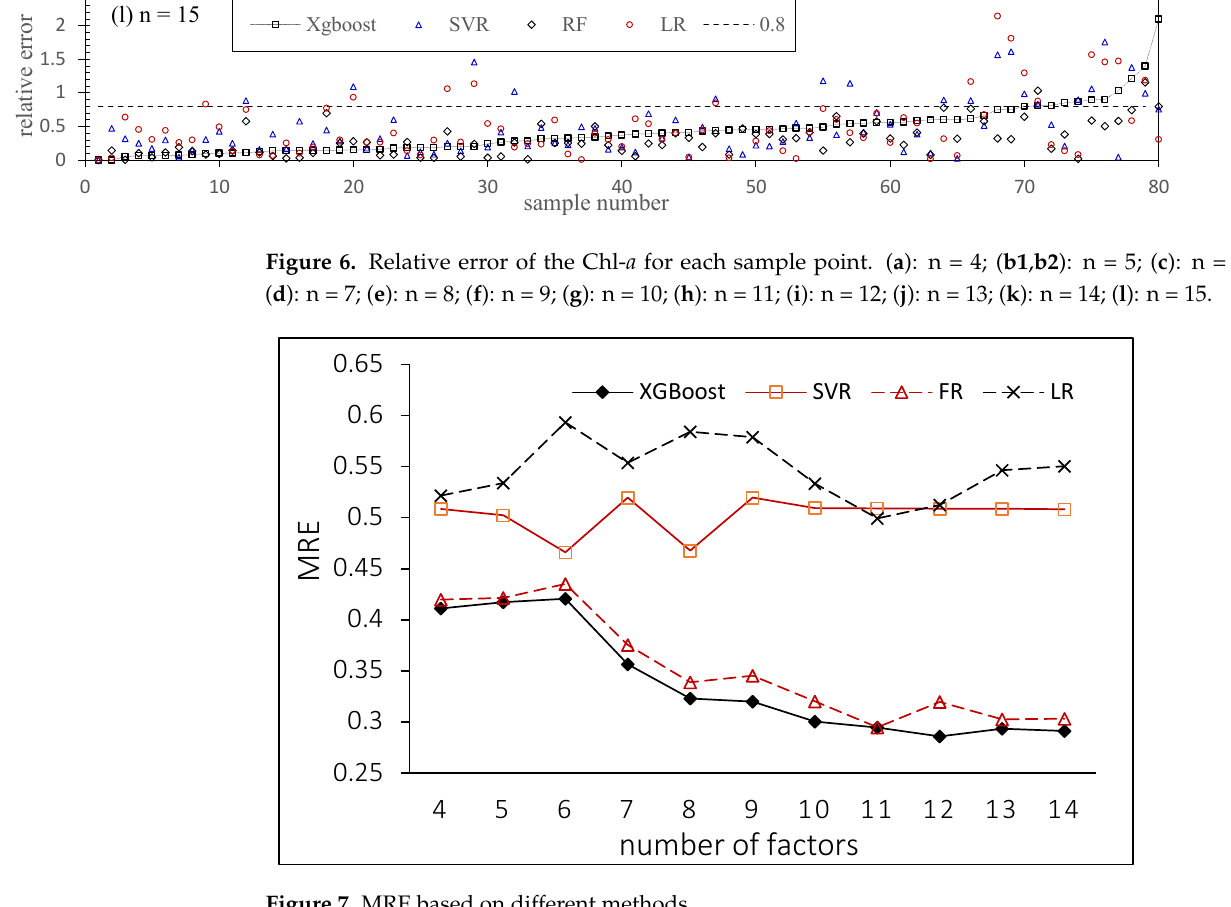
16 of 21 Figure 6. Relative error of the Chl- a for each sample point. ( a ): n = 4; ( b1 , b2 ): n = 5; ( c ): n = 6; ( d ): n = 7; ( e ): n = 8; ( f ): n = 9; ( g ): n = 10; ( h ): n = 11; ( i ): n = 12; ( j ): n = 13; ( k ): n = 14; ( l ): n = 15. It can be seen from Figure 6, the XGBoost, RF, SVR, and LR methods can be used for modeling and predicting the value of Chl- a . When RF and SVR were used for modeling and prediction, more large relative errors appeared in the results.